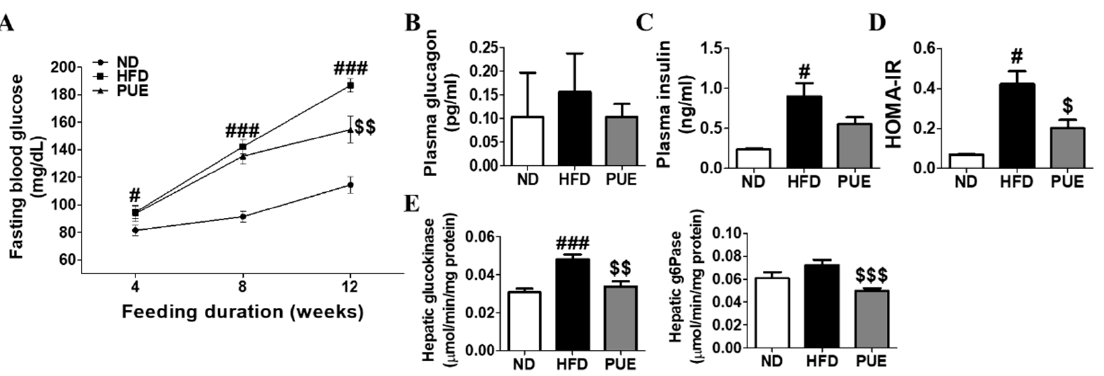
Figure 4. Effect of P. umbrosa root extract on glucose metabolism and insulin resistance in DIO mice. ( A ) Fasting blood glucose; ( B ) Plasma glucagon; ( C ) Plasma insulin; ( D ) HOMA-IR; ( E ) Hepatic glucogenic enzyme activity. ( A – E ) Data are presented as means ± SEM.; ND, normal diet (AIN-93G); HFD, high-fat diet (60 kcal% fat); PUE, HFD + P. umbrosa root extract (1% w / w ). Significant differ-